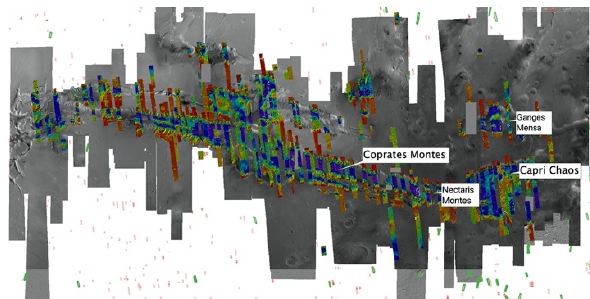
Figure 10. Map of HRSC-ORI of the panchromatic mosaic (Tao et al., in preparation) with superimposed CTX DTMs colourised by height and hill-shaded. Also shown are the footprints of HiRISE scenes (red) and CaSSIS around the perimeter (green).